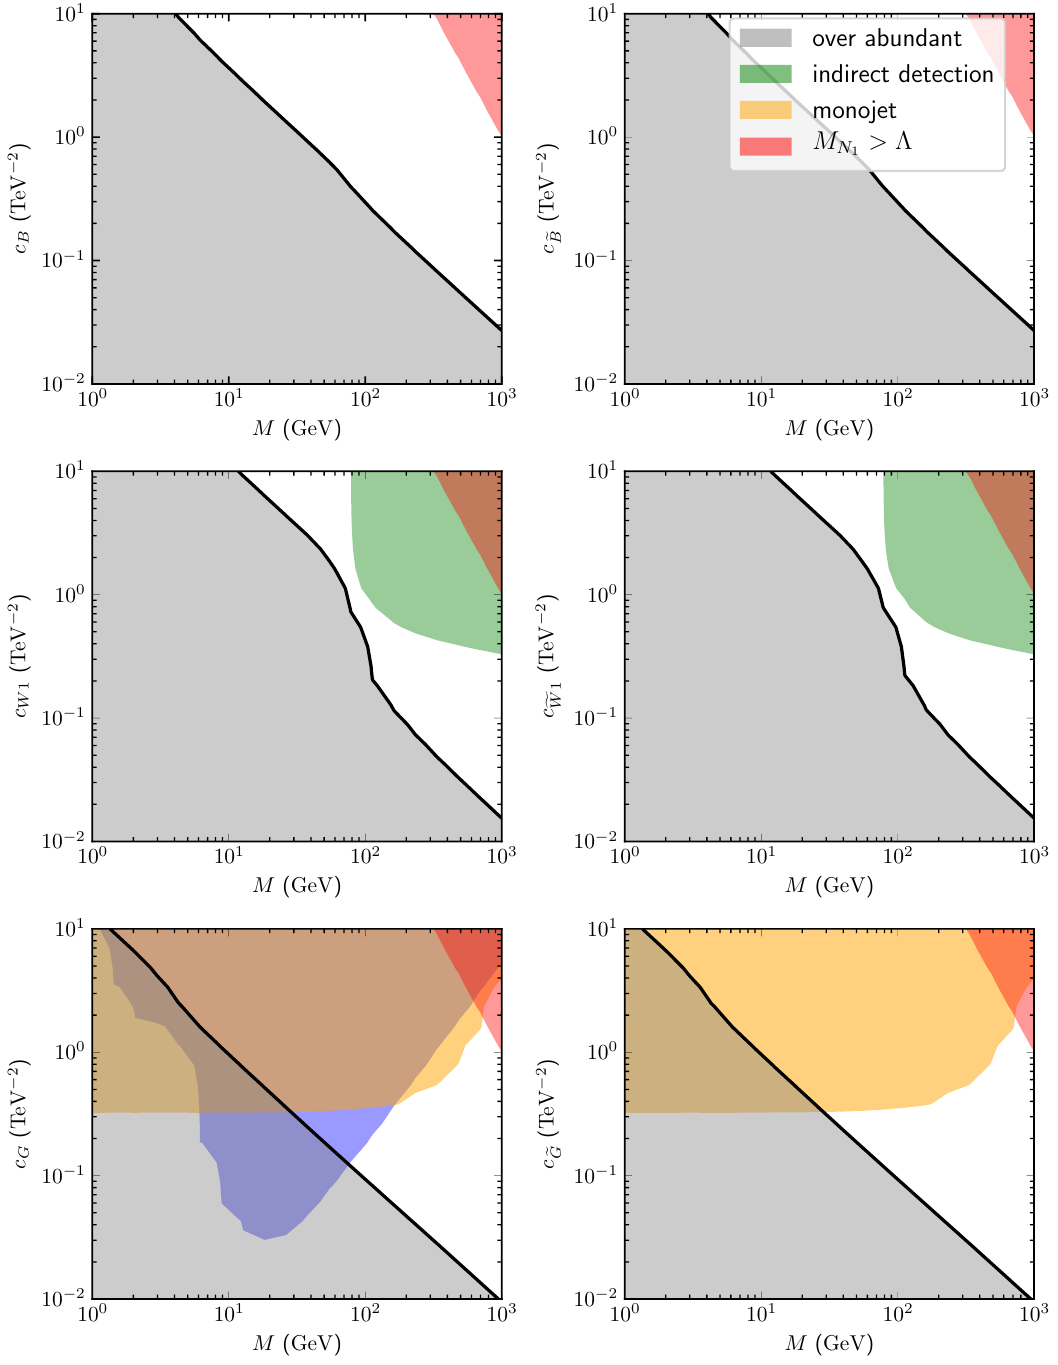
Figure 2 . Constraints on the coefficients of the operators coupling the scalar DM particle to gauge bosons, as a function of the DM particle mass. The points over the solid black line give the correct DM relic abundance. The gray region gives an overabundance of DM. The orange region is constrained by the analysis of monojet events performed by the CMS collaboration. The region excluded by the limit on the annihilation cross section set by Planck is shown in green. The EFT is no longer valid in the red